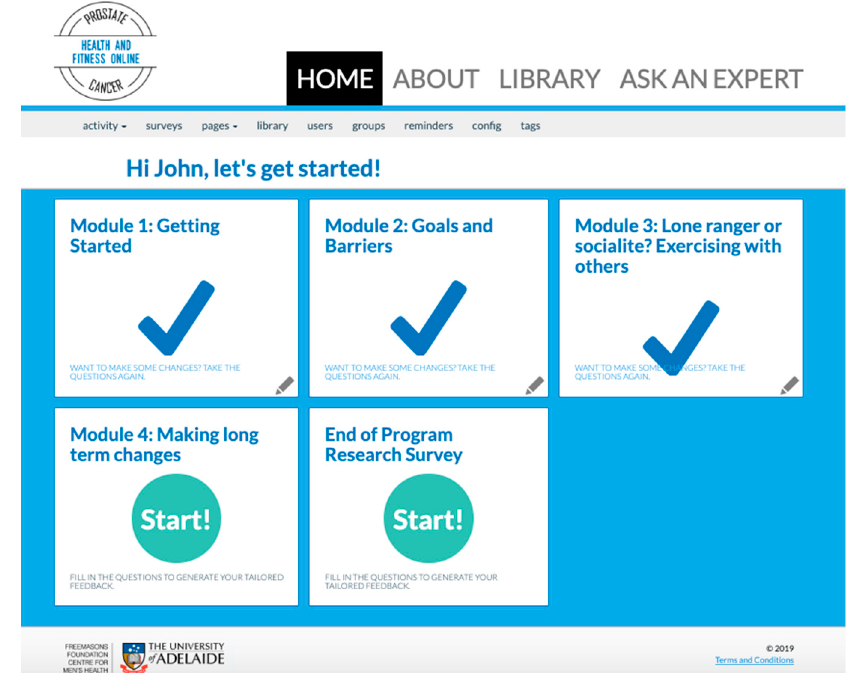
Figure 2. Tunnel website homepage (administrator view). A new module was unlocked each week, over four weeks; physical activity self-monitoring and feedback were provided within each module, alongside the “once-off” content designated to that week.